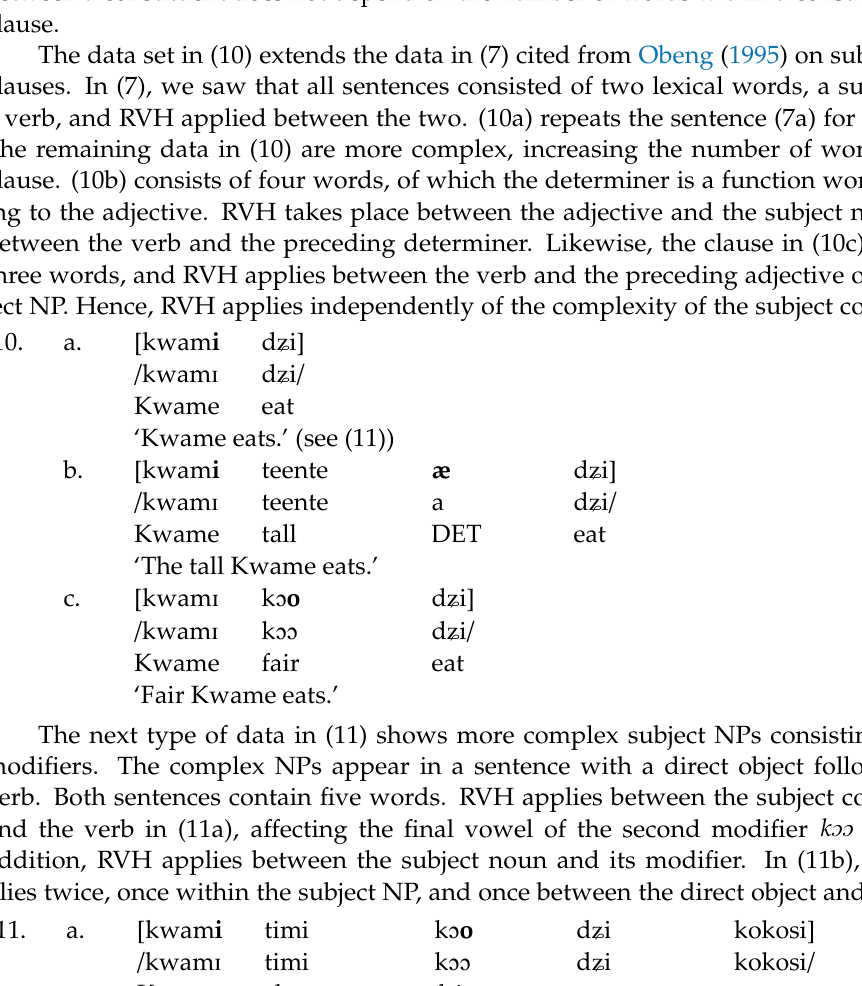
( b ) Figure 1. ( a ) Waveform, spectrogram of the noun k ɔ t ʊ ‘hat’; ( b ) Waveform, spectrogram of the NP k ɔ t ʊ bebree ‘many hats’. In complex NPs containing two modifiers, RVH also occurs between modifiers (8d- e). The quantifier bebree ‘many’ affects the final vowel of the preceding adjective, trigger- ing its assimilation to the [+ATR] vowel. In the case of (8d), the adjective k ɔɔ ‘red’ consists of two syllables. According to Ofori (2013), in sequences of two identical vowels, each vowel projects its own syllable. In line with RVH in other cases, RVH targets only the immediately adjacent vowel of the preceding word. 8. a.